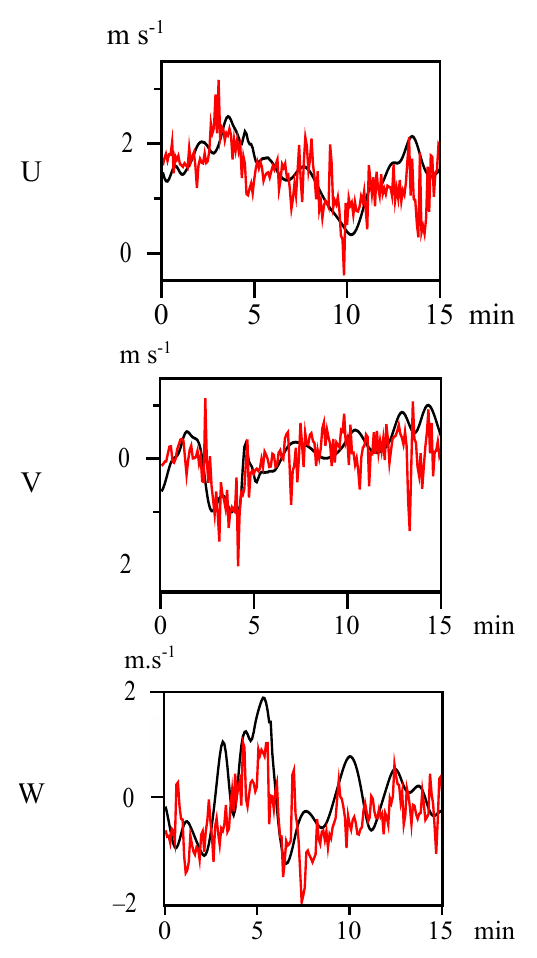
Figure 6. Time evolution of the three wind components obtained with the fine Meso-NH simulation (black) and with the particle model (red) for one cell of the fine